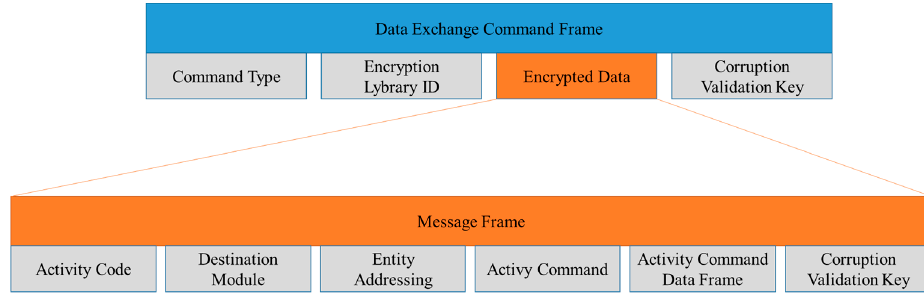
Figure 13. Data exchange command frame.